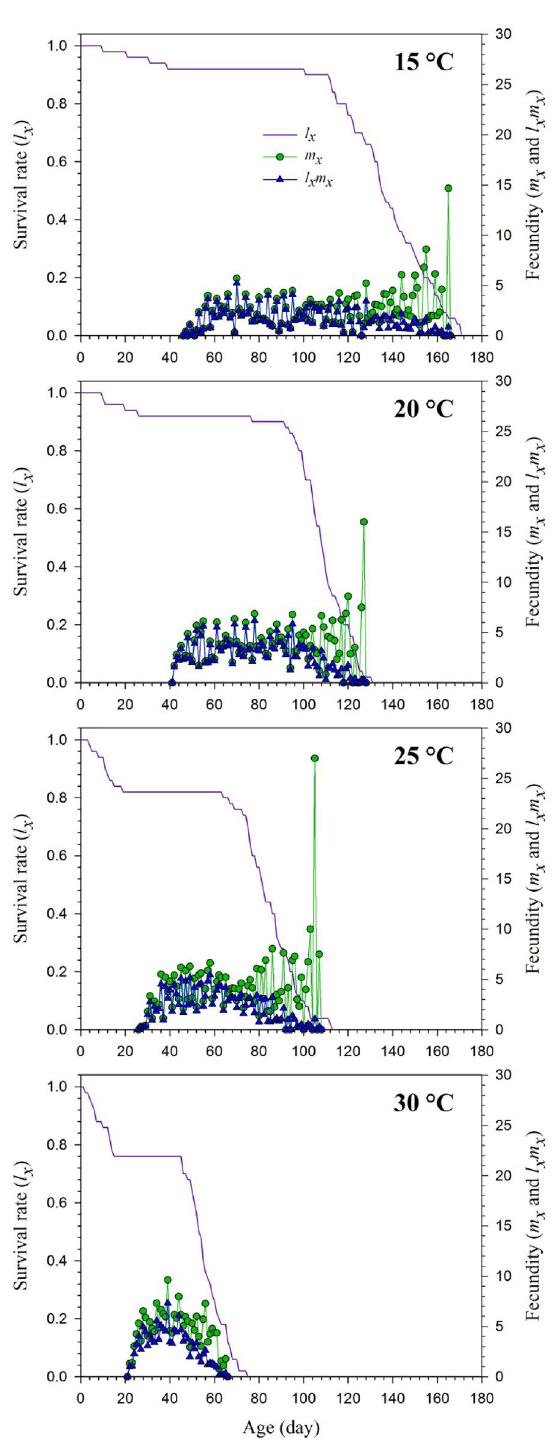
Figure 1. Age-specific survival rate ( l x ), age-specific fecundity ( m x ), and age-specific maternity ( l x m x ) of the Harmonia axyridis feeding on Spodoptera litura eggs at different